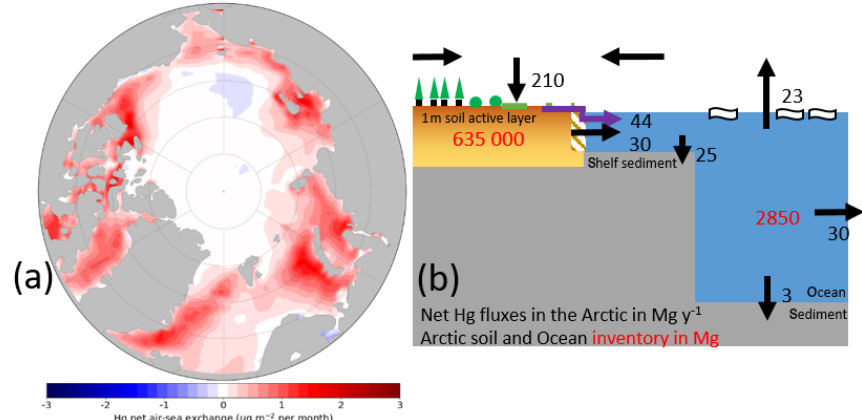
Figure 11. (a) Modeled net air–sea exchange of Hg (µgm − 2 per month) across the Arctic Ocean basin for the months June–July from the coupled GEOS-Chem–MITgcm Hg chemistry and transport model. Positive numbers (red) indicate a flux to the atmosphere. (b) The modern Arctic Hg cycle, showing net fluxes (metric tons per year, in black) between the different terrestrial, marine, and atmospheric reservoirs (metric tons, in red). The hatched area represents the coastal erosion Hg flux. The large river Hg flux (purple arrow) confirms a new paradigm in which tundra vegetation and soil uptake midlatitude Hg atmospheric emissions and transfer them to rivers and the Arctic Ocean. Reproduced from Sonke et al. (2018).